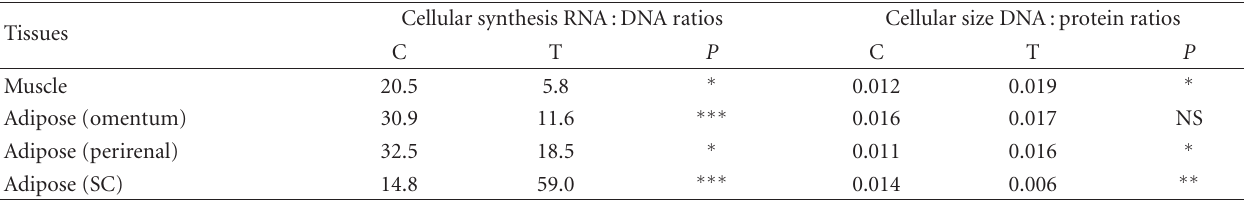
Table 2: Cellular synthesis and size in treated 2,4-Thiazolidinedione (TZD) (T), and Control (C) animals’ tissues. Tissues